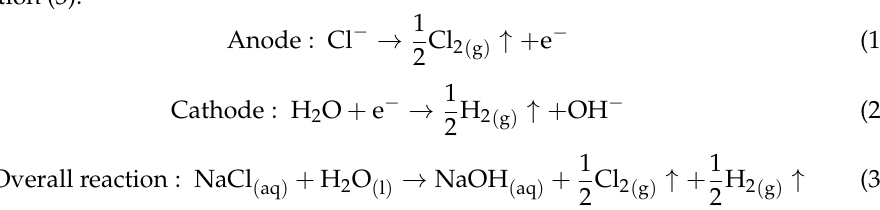
Figure 1. Schematic representation of a single-membrane-based chlor-alkali cell. An aqueous solution of 31 wt% NaOH is fed to the cathodic compartment, where (cid:1) (cid:0) water is reduced to H 2 and hydroxyl ions OH − according to Equation (2). Together with the sodium ions, these hydroxyl ions form NaOH. The depleted brine (206.6 gL − 1 NaCl) and the concentrated NaOH solution (32.5 wt% NaOH) are discharged from the anode and cathode compartments, respectively [35–37]. The overall cell reaction is given by Equation